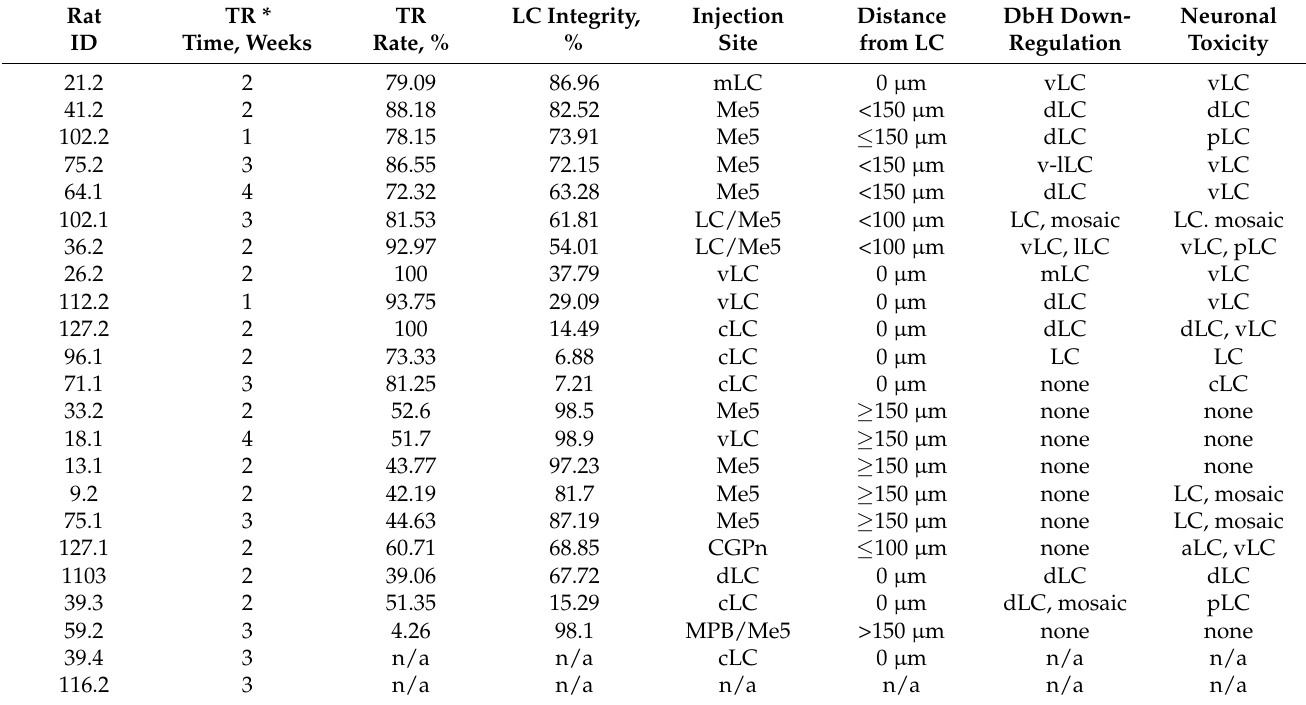
Table 1. Summary of histological examination of the injection sites in the LC area and quantitative analysis of immunohistological